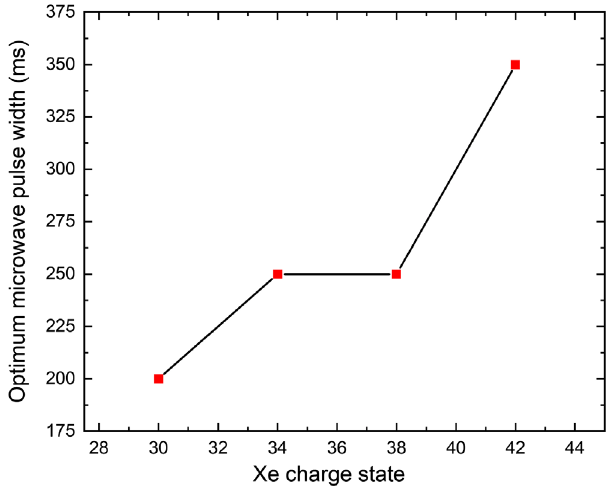
FIG. 7. Evolution of the optimum microwave pulse width with xenon charge